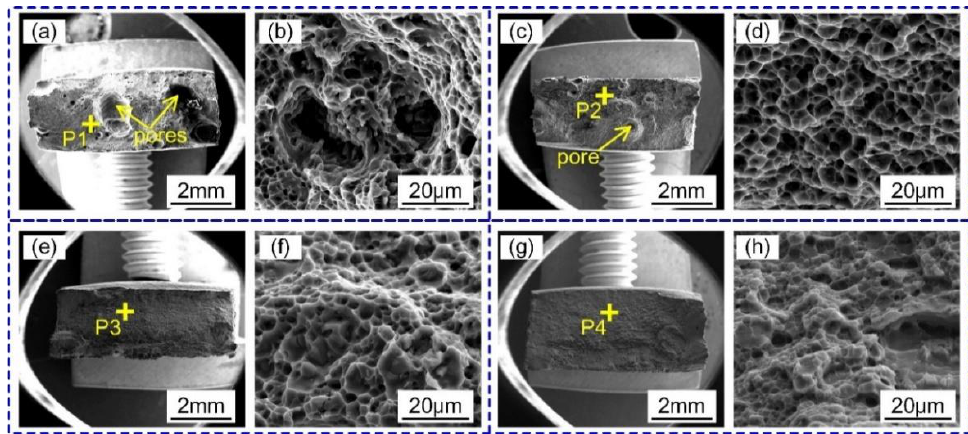
Figure 9. Morphologies of fracture surfaces, overviews of weld ( a ) #1, ( c ) #2, ( e ) #5 and ( g ) #8, details of ( b ) P1, ( d ) P2, ( f ) P3 and ( h ) P4.